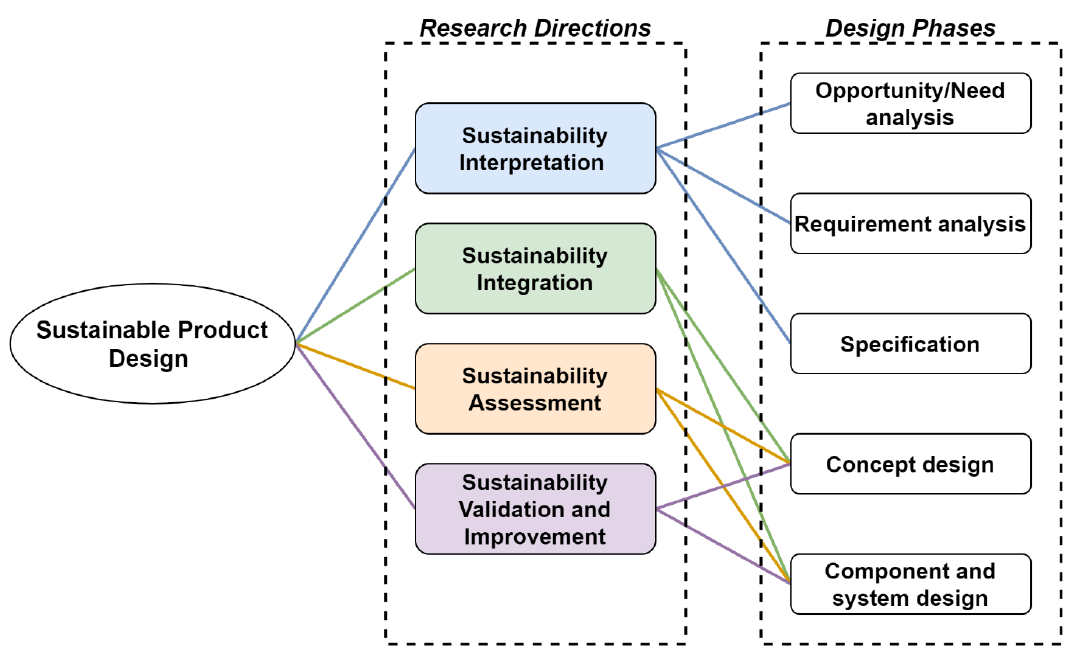
Figure 6. Future research directions in sustainable product design and their correlation with design phases.